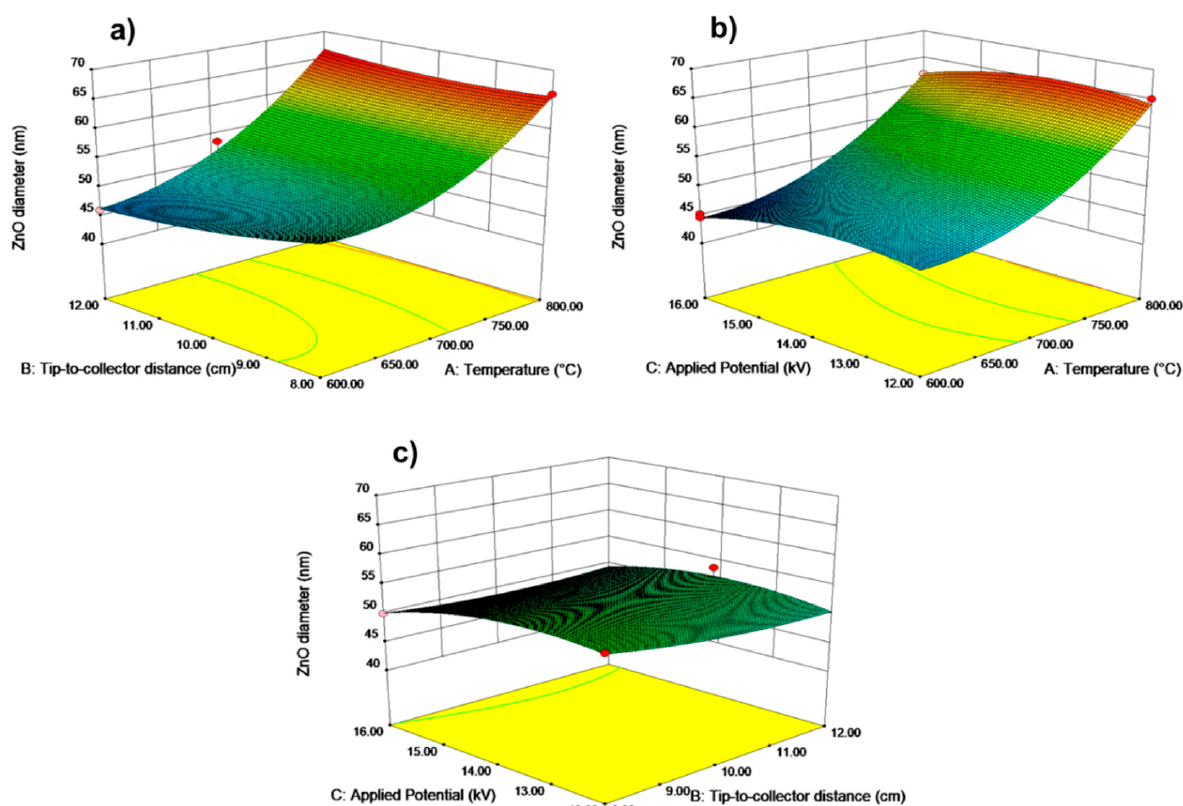
Figure 3. Response surface plots of ZnO diameter (response) versus ( a ) distance and temperature, ( b ) voltage and temperature, and ( c ) voltage and distance.